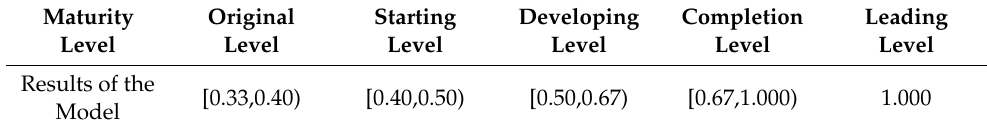
Table 5. Comparison of Safety Culture Maturity